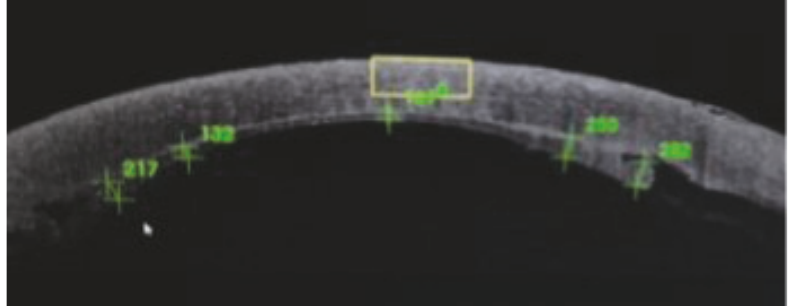
Figure 7: Incomplete reattachment after rebubbling.